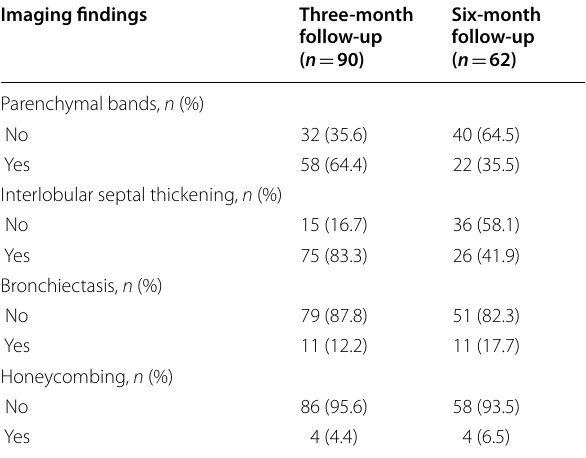
Table 3 Lung fibrotic-like changes in chest CT scan at